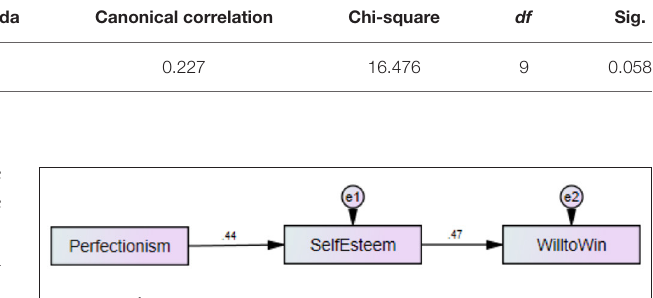
An independent-samples t -test was conducted to compare the self-esteem, will-to-win, and perfectionism scores of male and female participants. There was a significant difference in the self- esteem scores of male ( M = 30.84 ± 6.83) and female